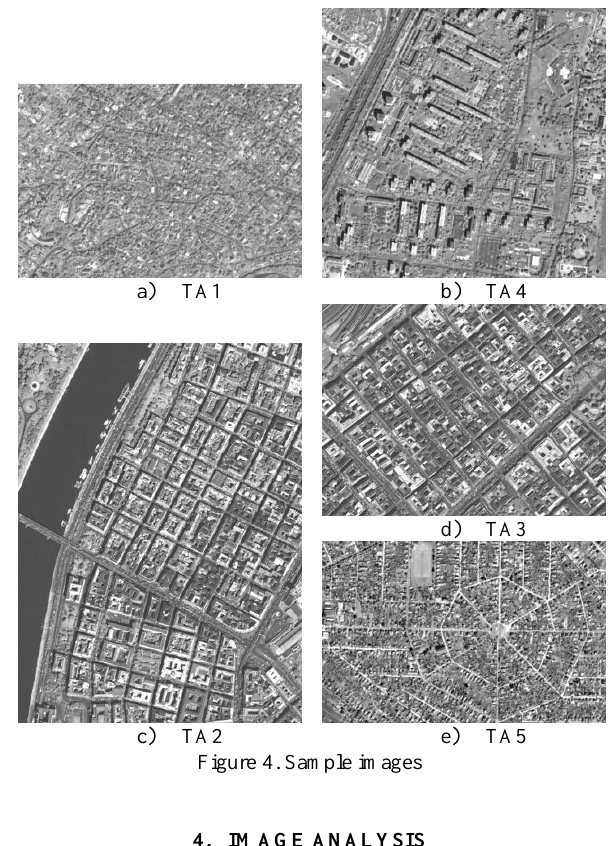
Figure 4. Sample